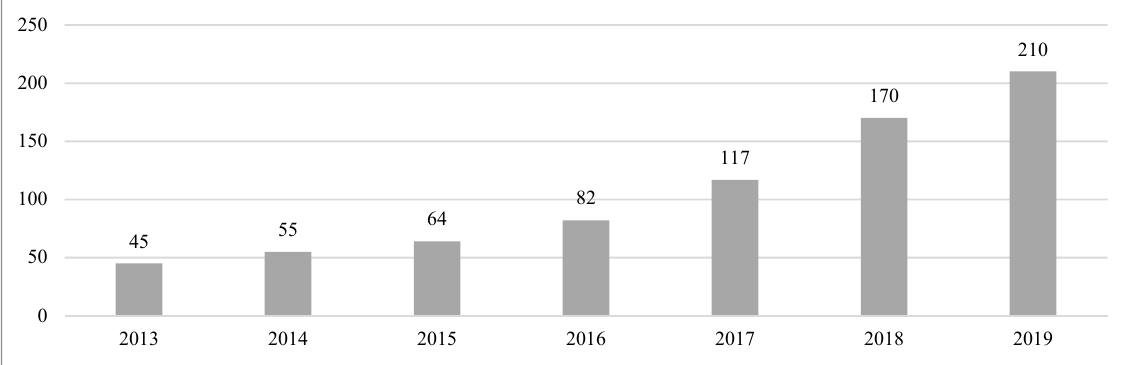
Figure 4. FinTech sector in Lithuania by activity. We started the analysis of interaction using the main descriptive statistics parame- ters (Table 1). Table 1. FinTech sector descriptive statistics. (Composed by the Authors using data of Invest in Lithuania, 2019). Number of FinTech Companies Average Median